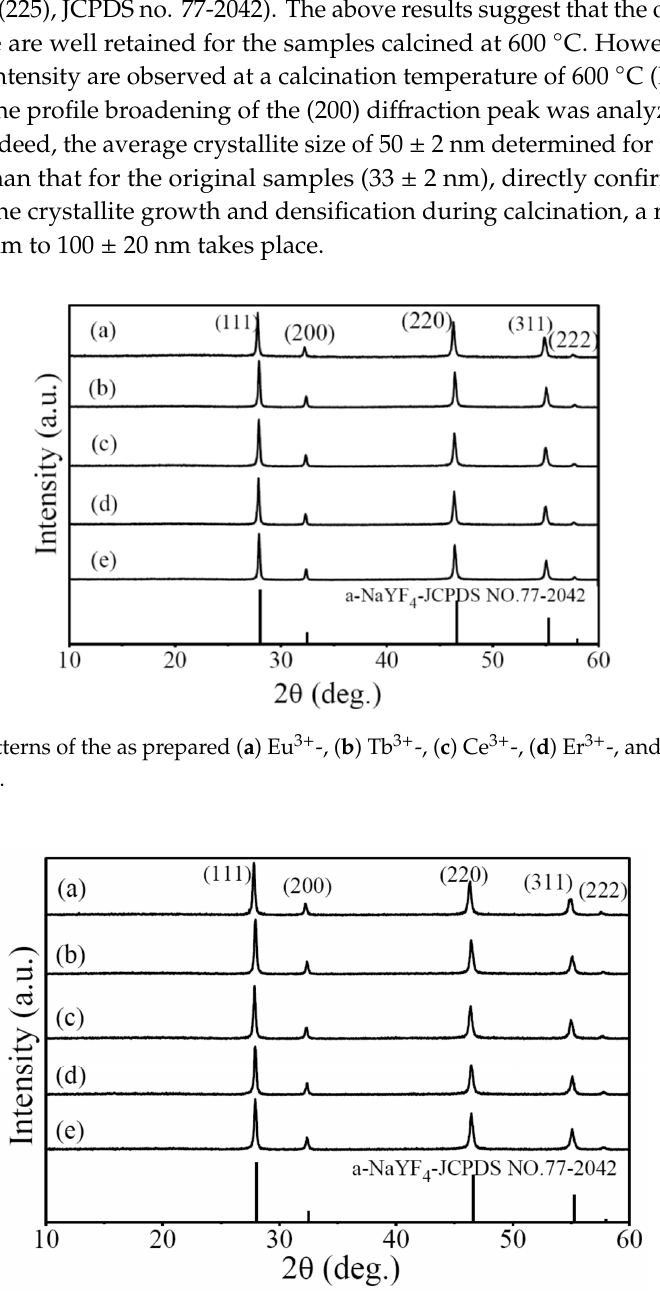
Figure 1. FE-SEM ( a – e ) and TEM ( f ) micrographs showing morphologies of the as prepared ( a,f ) Eu 3+ - , ( b ) Tb 3+ -, ( c ) Ce 3+ -, ( d ) Er 3+ -, and ( e ) Tm 3+ -doped α-NaYF 4 samples, respectively. The inset in ( f ) is the selected area electron diffraction (SAED) patterns of Eu 3+ -doped sample.